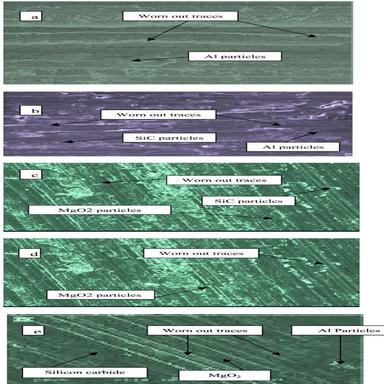
(a, b, c, d) SEM images of the specimens after wear test. (a) Pure aluminum FGM. (b) Al-SiC FGM. (C) Al-MgO2 FGM. (d) Al-SiC-MgO2 FGM.